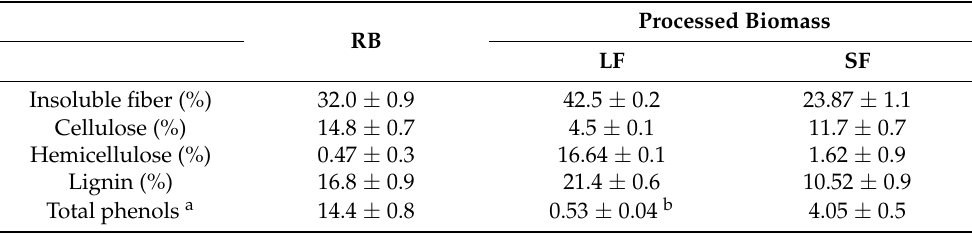
Table 3. Structural analysis of raw (RB) and processed Sargassum spp. biomass from the Mexican Caribbean: liquid (LF) and solid fraction (SF) on a dry basis ( n = 2). Processed Biomass RB